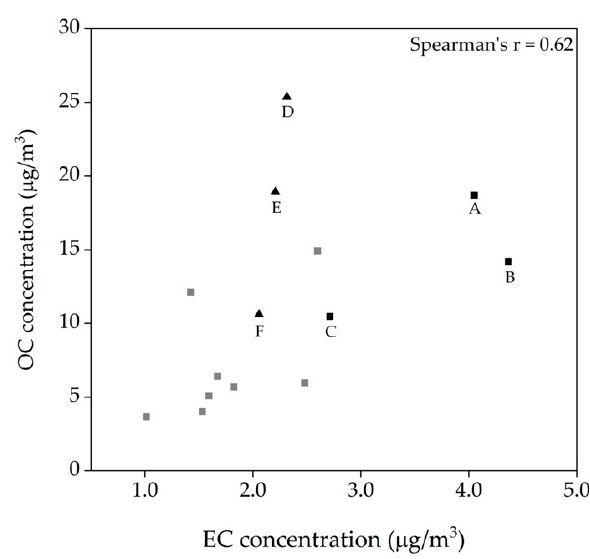
Figure 5. Scatterplot between organic carbon (OC) and elemental carbon (EC) concentrations in PM 2.5 samples at the urban sampling site in Graz DB, 2 January–31 March 2017. Black highlighted squares mark time periods with DB / BB PM 10 ratios > 2 (A: 2 January–3 January 2017; B: 11 January–12 January 2017; C: 21 February–23 February 2017). Black highlighted triangles mark time periods with DB / BB PM 10 ratios ≤ 1.5 (D: 22 January–23 January 2017; E: 31 January–2 February 2017 and F: 9 February–17 February 2017). Remaining data points are shown by grey squares.